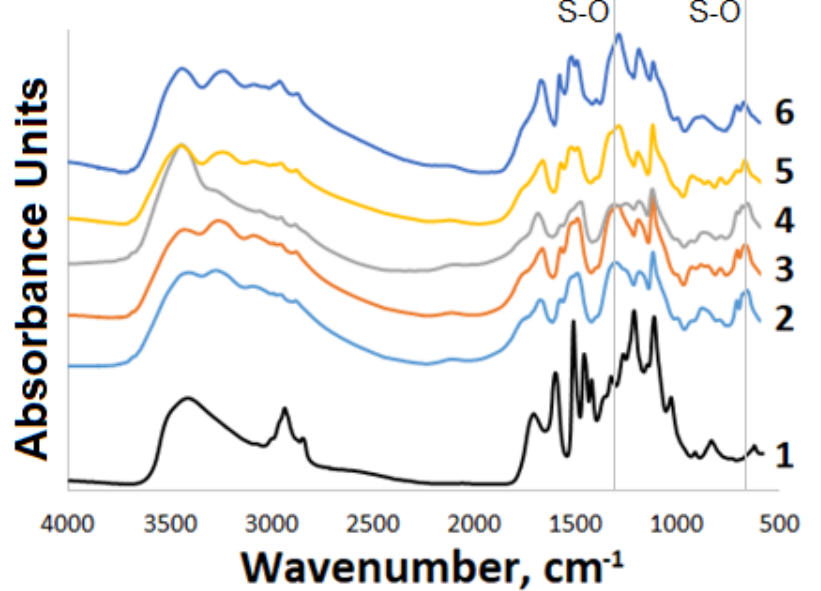
Figure 1. FTIR spectra of modified WSSL: (1) initial and obtained with (2) the Sibunit ‐ ox ‐ 500 g, (3) Sibunit ‐ ox ‐ 400, (4) Sulfated Sibunit, (5) TiO 2 , and (6) γ‐ Al 2 O 3 catalysts. (3) Sibunit-ox-400, (4) Sulfated Sibunit, (5) TiO 2 , and (6) γ -Al 2 O 3